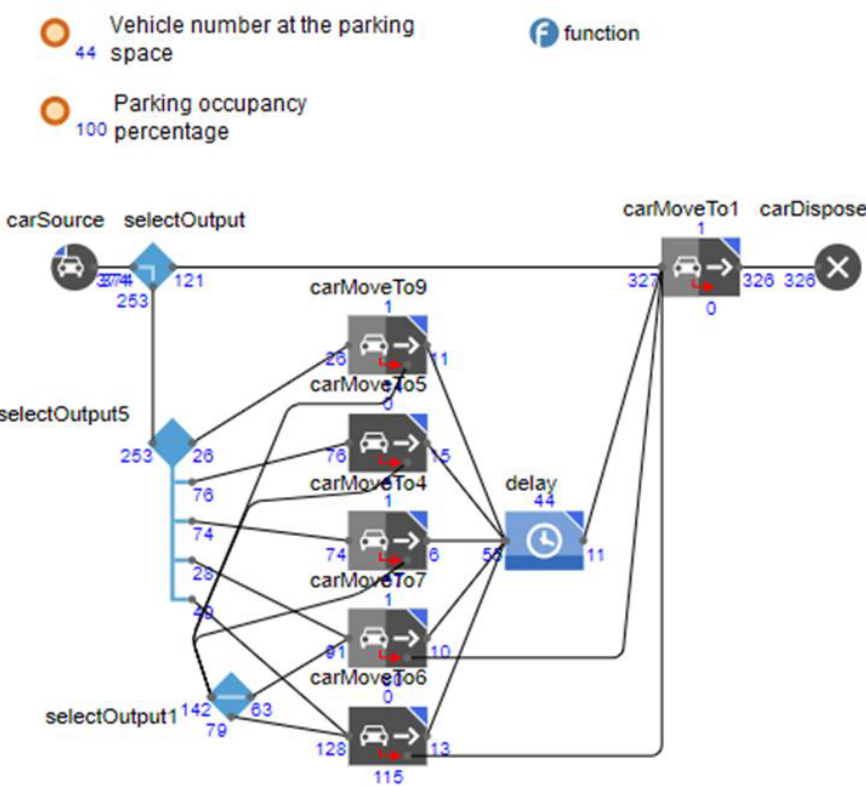
Figure 7. Simulation experiment.